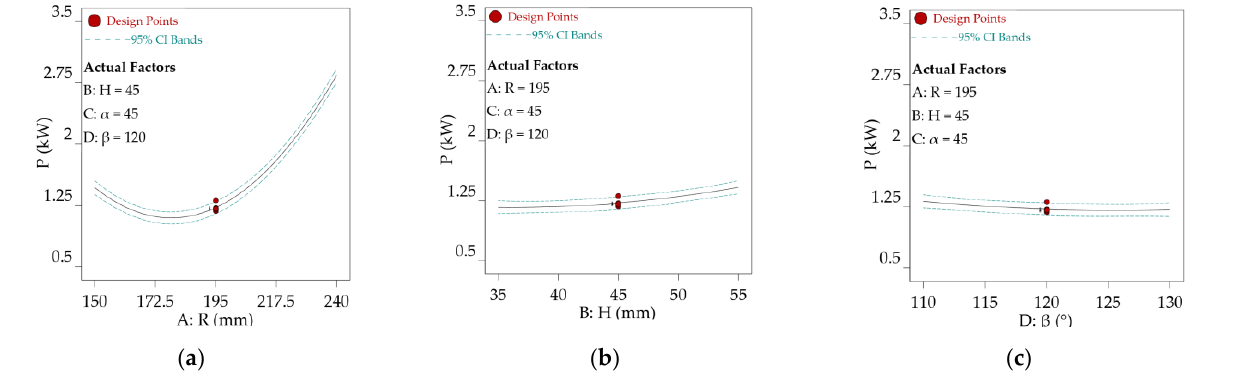
Figure 10. Power consumption value at different factors.